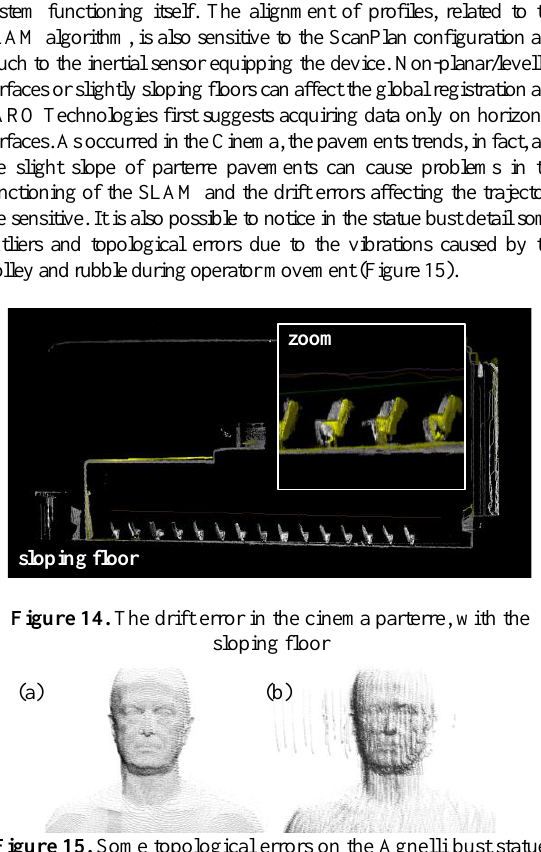
Figure 15. Some topological errors on the Agnelli bust statue due to the vibrations of the trolley in (a) TLS and (b)